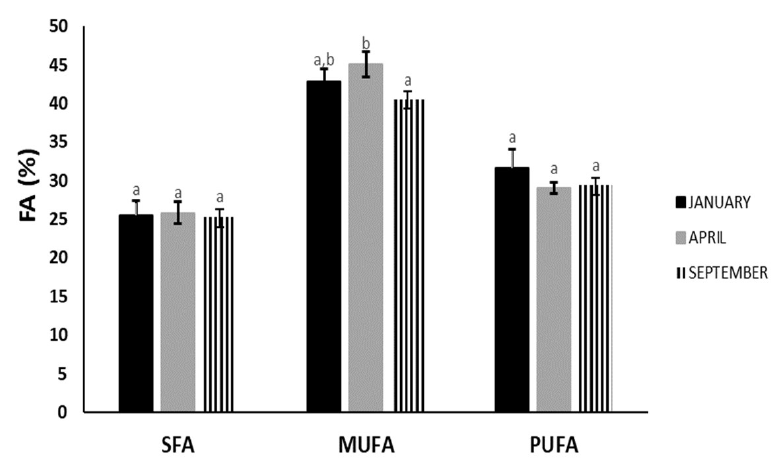
Figure 4. Fatty acid composition of sea bream samples caught in September 2020, January 2021, and April 2021 (SFA: Saturated Fatty Acids, MUFA: Monounsaturated fatty acids, PUFA: Polyunsaturated fatty acids). Different letters within the same set of columns indicate statistically significant difference.